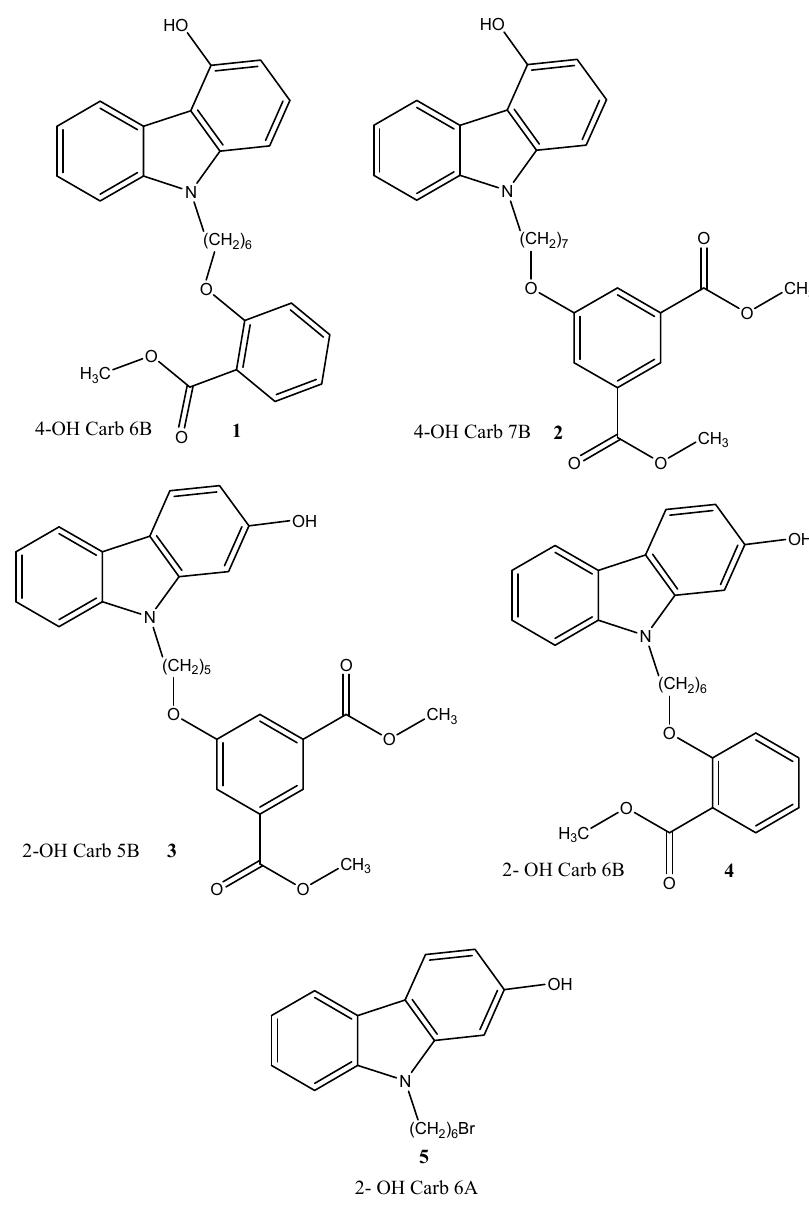
Figure 1. N -alkyl carbazole